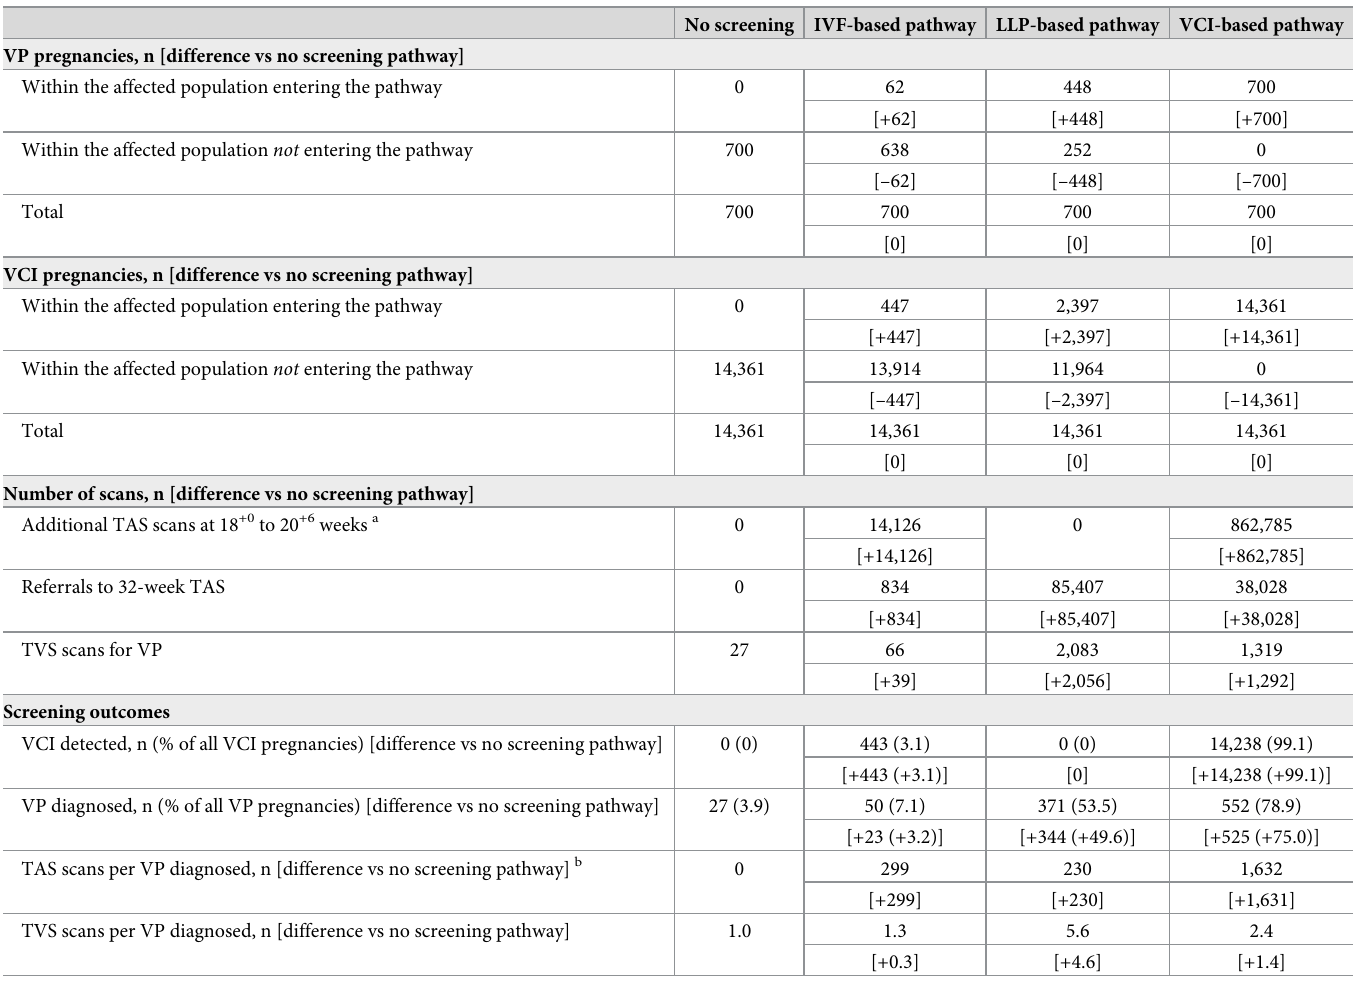
Table 3. Base case results for demographic and screening